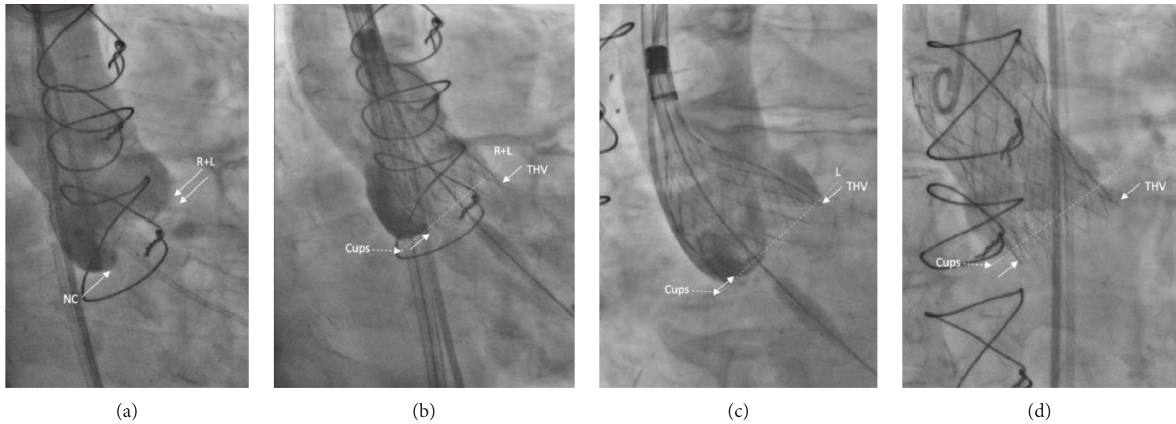
Figure 2: THV implantation in the right and left cusp-overlap view. (a) COVL view (right and left cusps overlap in the RAO caudal view). (b) THV positioning in the COVL view. (c) 3-cusp conventional view during positioning (LAO cranial) where THV locks higher than the COVL view. (d) After final delivery in the COVL view (34mm Evolute R ™ THV). COVL � cusp-overlap view, RAO � right anterior oblique, THV � transcatheter heart valve, LAO � left anterior oblique.